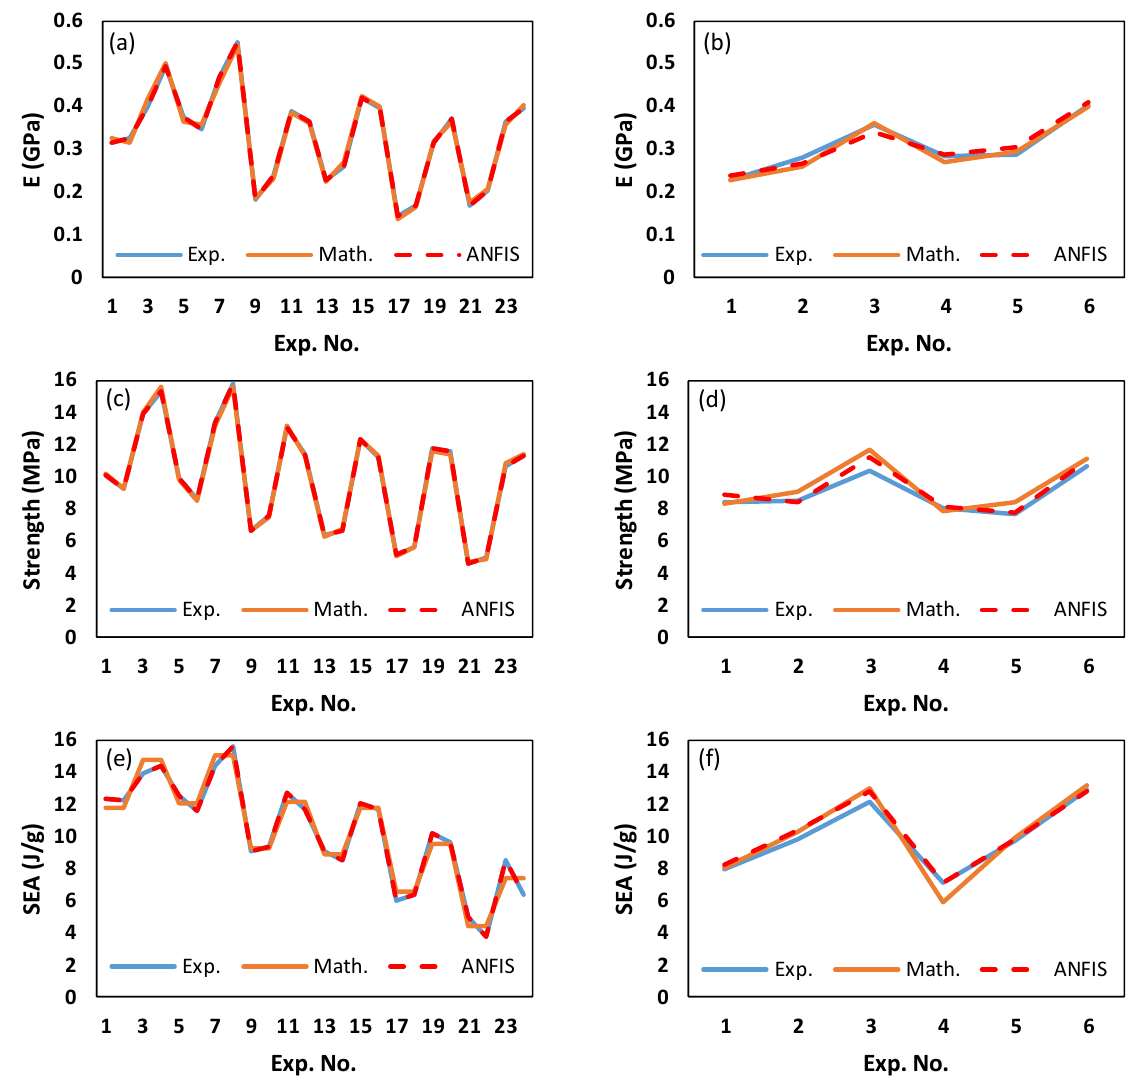
Figure 16. Comparison between experimental, mathematical, and ANFIS results for the training and testing data sets: ( a ) training data of E, ( b ) testing data of E, ( c ) training data of σ peak , ( d ) testing data of σ peak , ( e ) testing data of SEA, and ( f ) training data of SEA. Table 11. RMSE of the mathematical and ANFIS prediction models based on the testing data set.